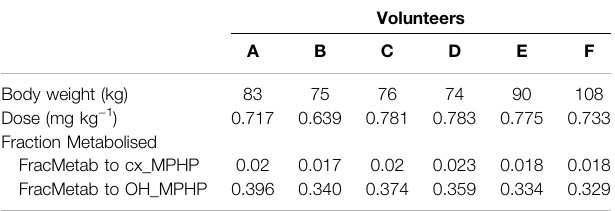
TABLE 2 | Volunteer speci fi c